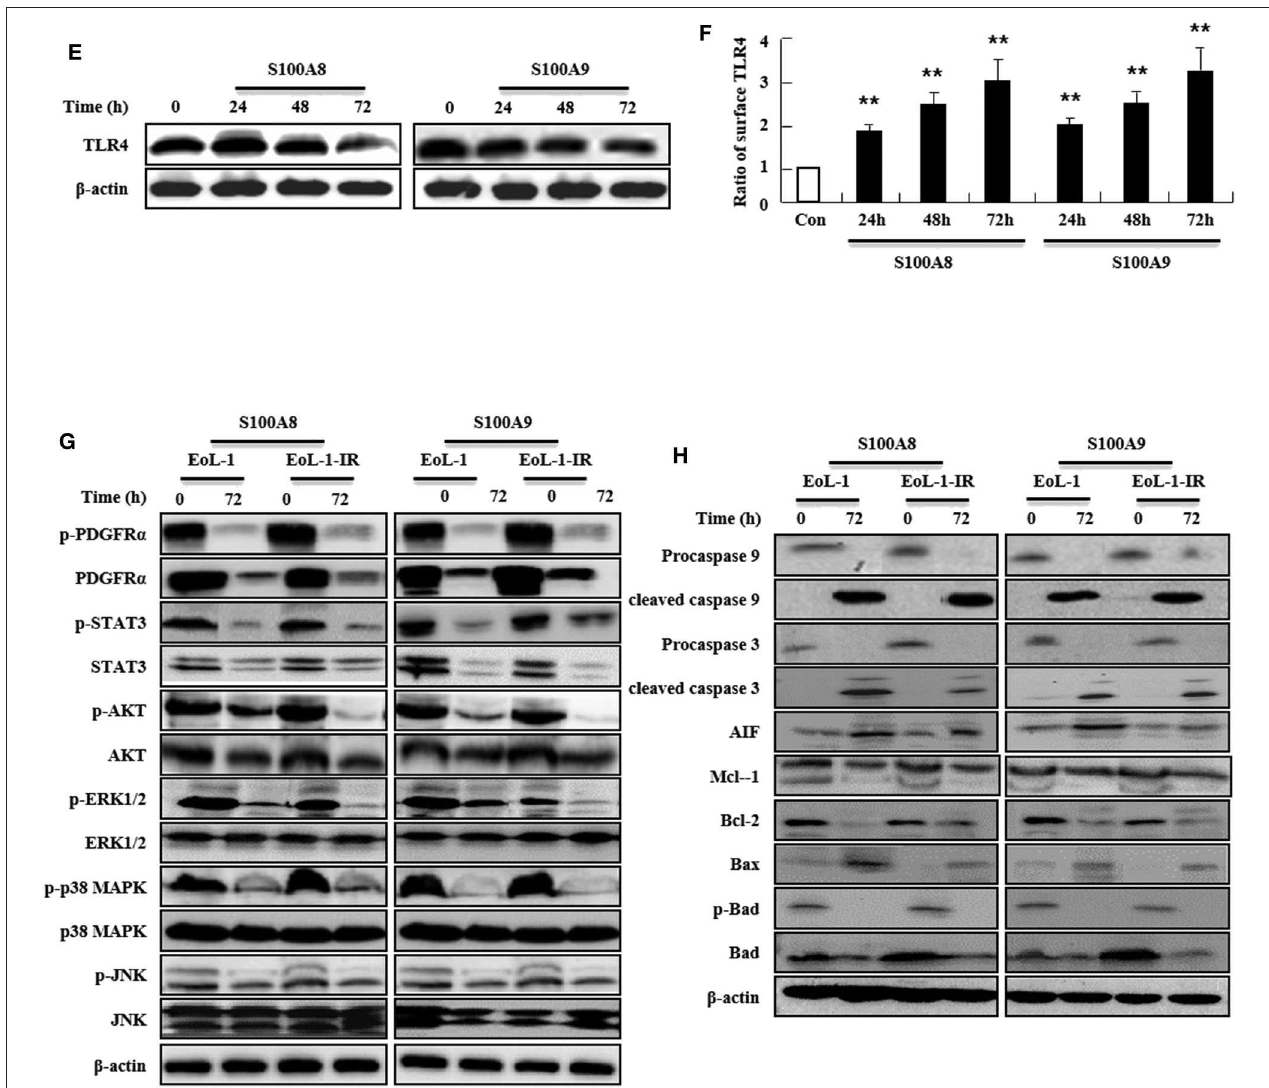
FIGURE 4 | S100A8 and S100A9 trigger apoptotic effects on EoL-1-IR cells. (A) EoL-1 and EoL-1-IR cells were incubated for 24, 48, and 72h in the absence (Con) or presence of imatinib at the indicated concentration. Apoptosis was analyzed by measuring the binding of annexin V-FITC and PI. (B) EoL-1 and EoL-1-1R cells were incubated for 72h in the absence or presence of imatinib at the indicated concentration. Following cell lysis, phosphorylation and non-phosphorylation of PDGFR α , STAT3, AKT, ERK1/2, p38 MAPK, and JNK in the lysates were detected by Western blotting. (C,D) EoL-1 and EoL-1-IR cells were incubated for 24, 48, and 72h in the absence (Con) or presence of indicated concentrations of S100A8, S100A9 (C) , LPS (100ng/mL) and MPLA (100ng/mL) (D) ( n = 3). Apoptosis was analyzed by measuring the binding of annexin V-FITC and PI. (E,F) EoL-1-IR cells were incubated for 24, 48, and 72h in the absence (Con) or presence of S100A8 and S100A9 (10 µ g/mL), and TLR4 expression was detected using Western blotting (E) and flow cytometry (F) . Data are expressed as the means ± SD . * p < 0.05 and ** p < 0.01 indicate a significant difference between the control and stimulator-treated groups. (G,H) EoL-1 cells were incubated with S100A8 and